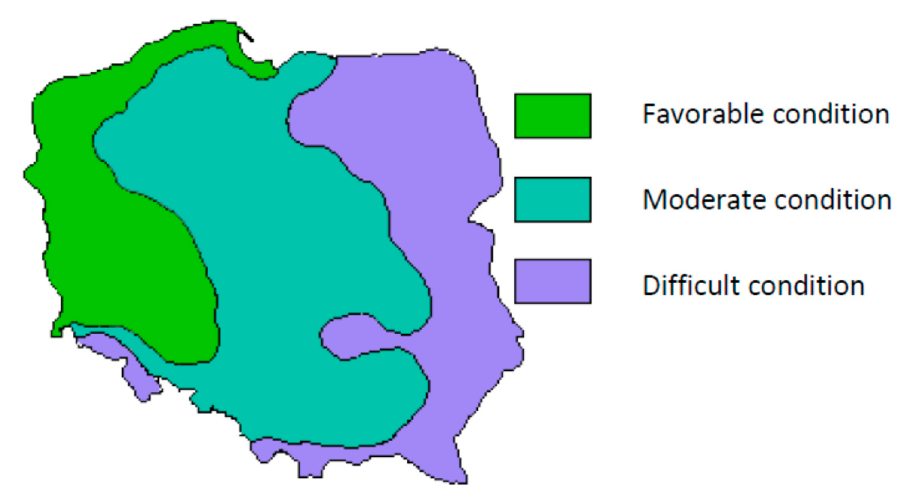
Figure 3. Distribution of zones for the cultivation of sensitive plants in Poland. Source: Hoser Sz. Fargesia [59].